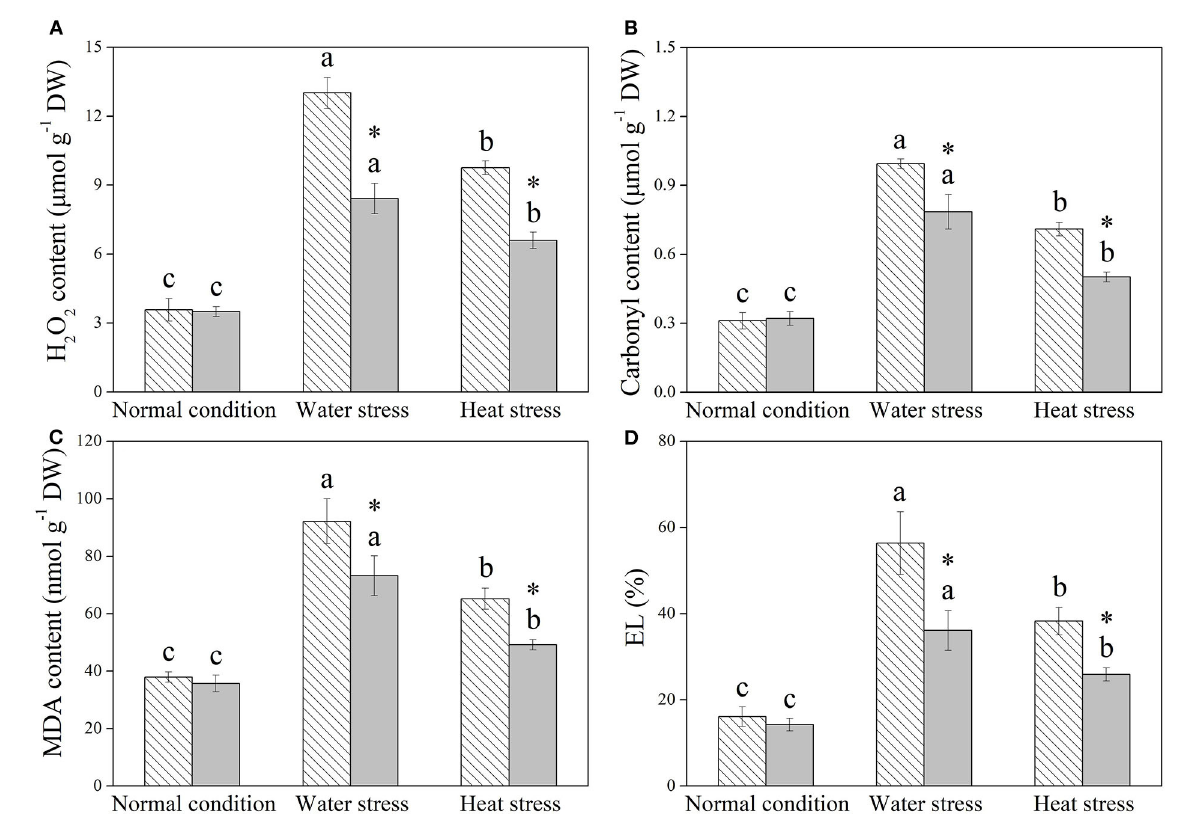
FIGURE4 Changes in endogenous (A) hydrogen peroxide (H 2 O 2 ), (B) carbonyl content, (C) malonaldehyde (MDA), and (D) electrolyte leakage (EL) in response to Spm application under different conditions. Vertical bars indicate ± SE of the mean ( n = 4). Different letters above striated or gray columns indicate significant differences for a particular treatment (Control or + Spm) for comparison across the normal condition, water stress, and heat stress; the asterisk “*” indicates significant differences between the control and the + Spm treatments under one particular condition (normal condition, water stress, or heat stress) based on LSD ( P <